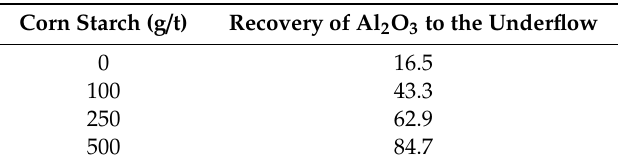
Table 6. The e ff ect of corn starch dosage on the recovery of Al 2 O 3 to the underflow on the sedimentation tests with the iron ore slime (sample 1).